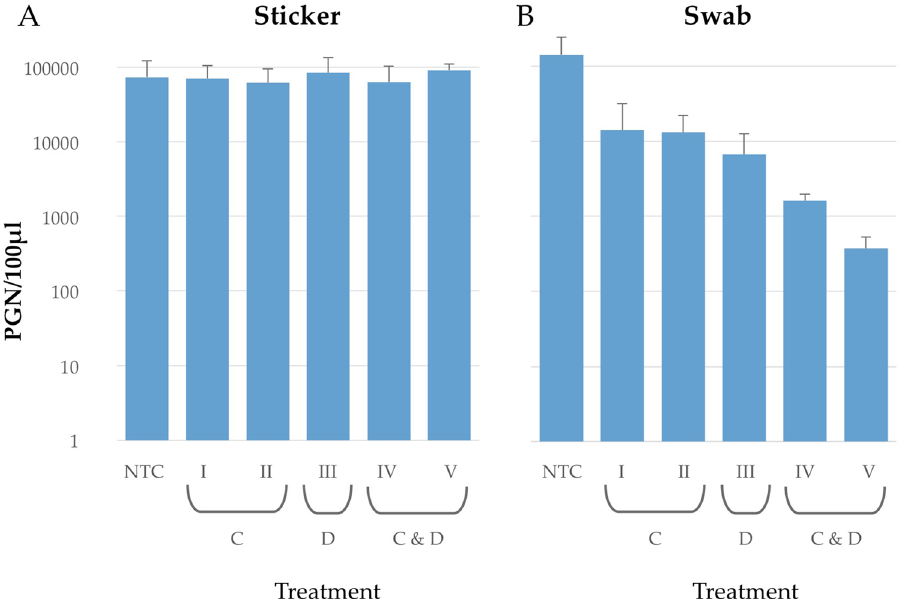
Figure 3. Viral genome recovery rate after cleaning and disinfection of paper-based stickers and cotton swabs. Surfaces or stickers applied to surfaces were artificially contaminated with a concentration of approximately 10 6 PGN/100 µL. After drying, surfaces were treated with different methods, sampled, DNA extracted and analysed with qPCR. Treatments comprised a no treatment control (NTC), two cleaning treatments (C) (I) flush with water, (II) flushed with soapy water, the disinfection treatment (D) (III) wiped with Mirkozid and combined treatments (C and D) (IV) cleaning with BUDENAT ALKASEPT D 445 and wiped with Mikrozid, and (V) flushed with soapy water and wiped with Mikrozid. Each experiment was performed at least in triplicate and bars show mean values with respective standard deviations. Data were analysed using the Kruskal–Wallis test of independent